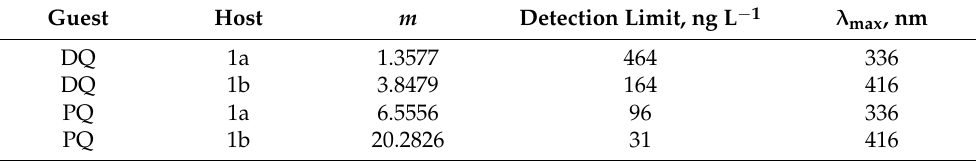
Table 7. Detection limits calculated for paraquat, PQ, and diquat, DQ, by fluorescence